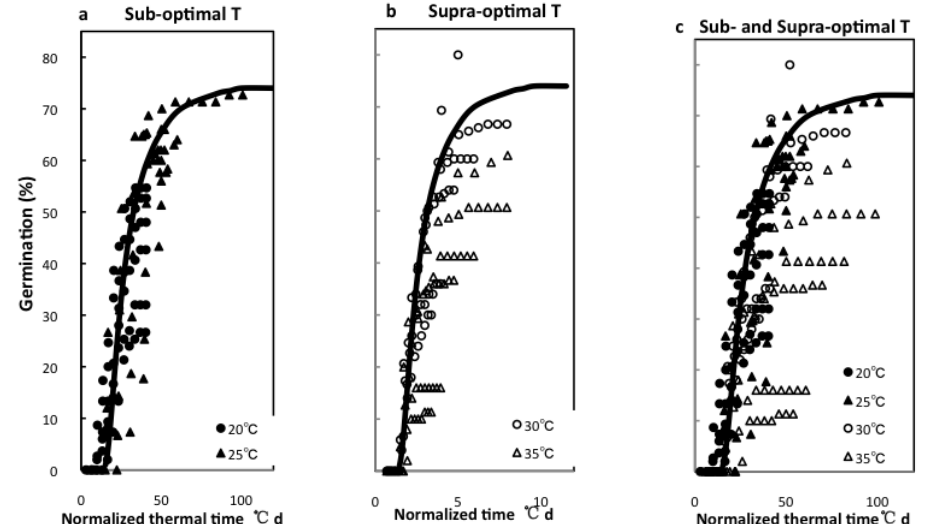
Fig. 4: Normalized time courses of the hydrothermal time model at sub-optimal temperatures (a), supra-optimal temperatures (b) and all temperatures com- bined